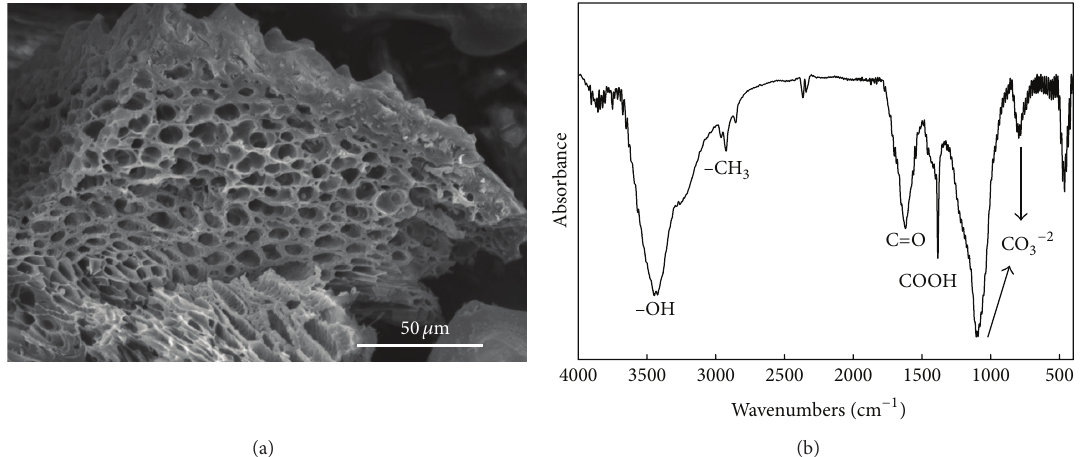
Figure 2: Scanning electron microscope (SEM) images (a) and Fourier-transform infrared (IR) spectrums of the rice hull biochar (RHB-400)